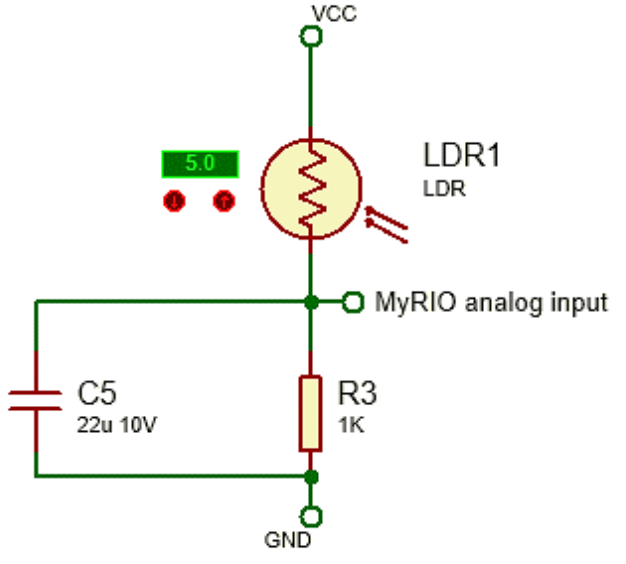
Figure 9. Photocell circuit setup.